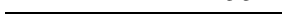
Table 11 Absorption capacity of different heavy metals on GO MMM